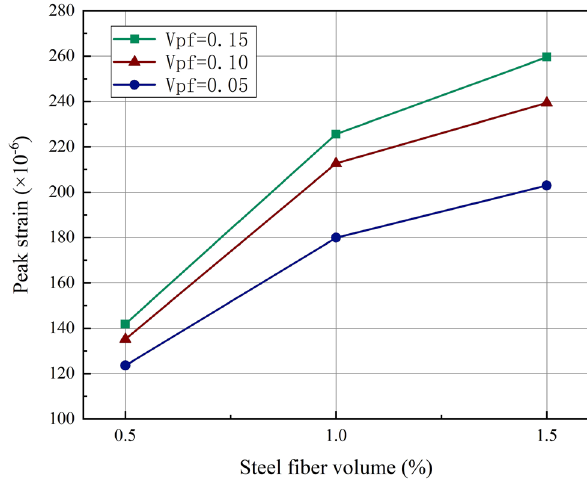
Figure 14: Peak strain values of the model for di ff erent fi ber